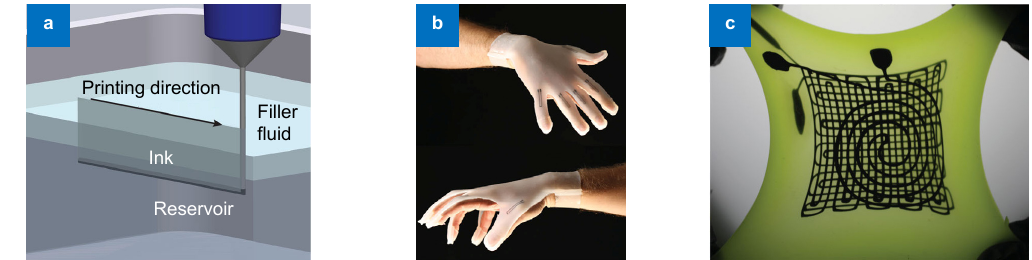
Fig. 9 | Schematic illustration of the embedded 3D printing (e-3DP) process and printed stretchable electronics 11 . ( a ) Schematic illustration of the e-3DP process. ( b ) Photograph of a glove with embedded strain sensors produced by e-3DP. ( c ) Photograph of a three-layer strain and pressure sensor in the stretched